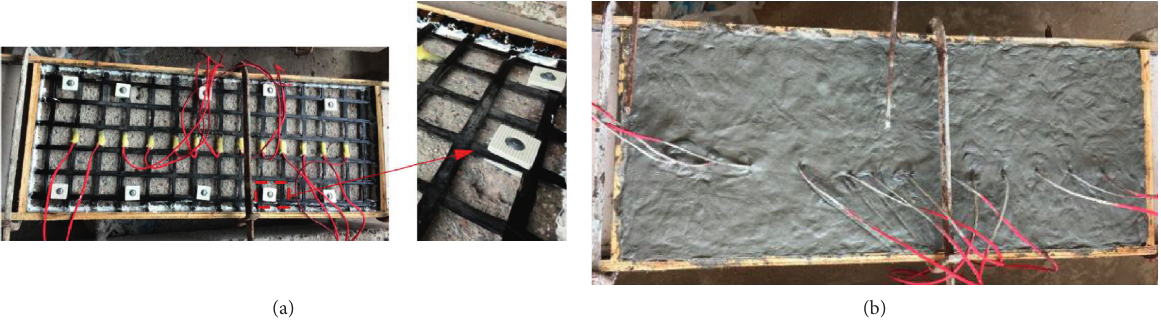
Figure 5: Installation procedures for the cast-in-place method